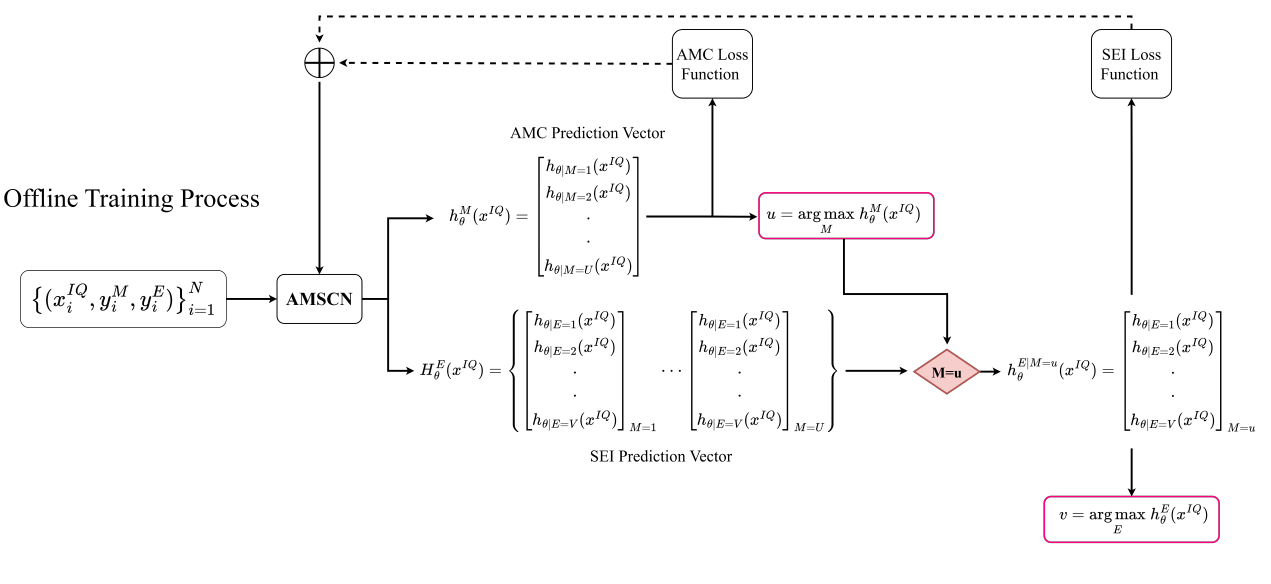
Figure 3. Offline training process of the proposed